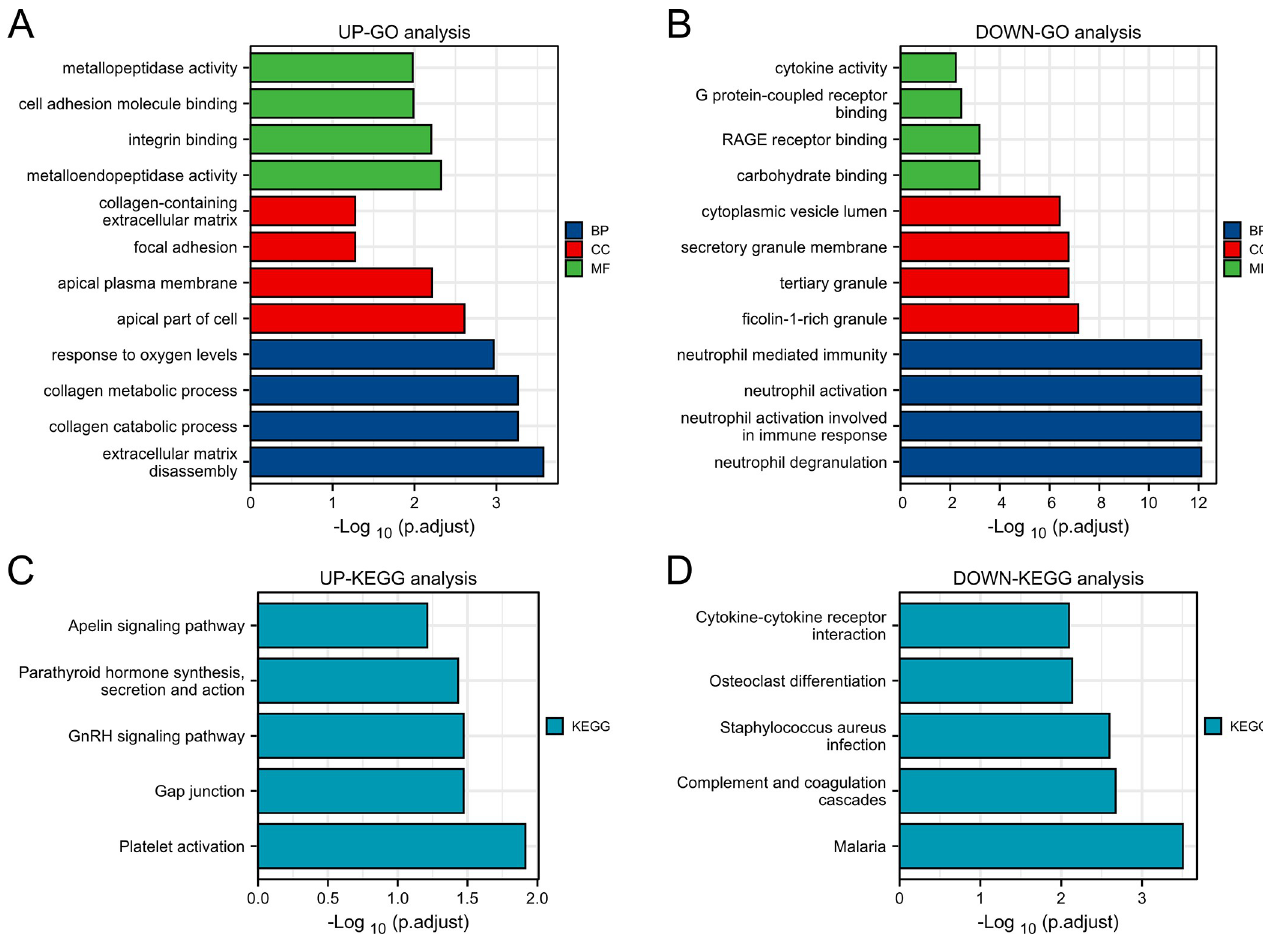
Fig 3. (A, B) Identification results of biological processes, cellular components and molecular functions related to GO terms based on a composite score. The higher the enrichment score, the higher the number of genes involved in a given ontology. (C, D) Identification of pathway analysis results by KEGG. The results of pathway term identification by composite